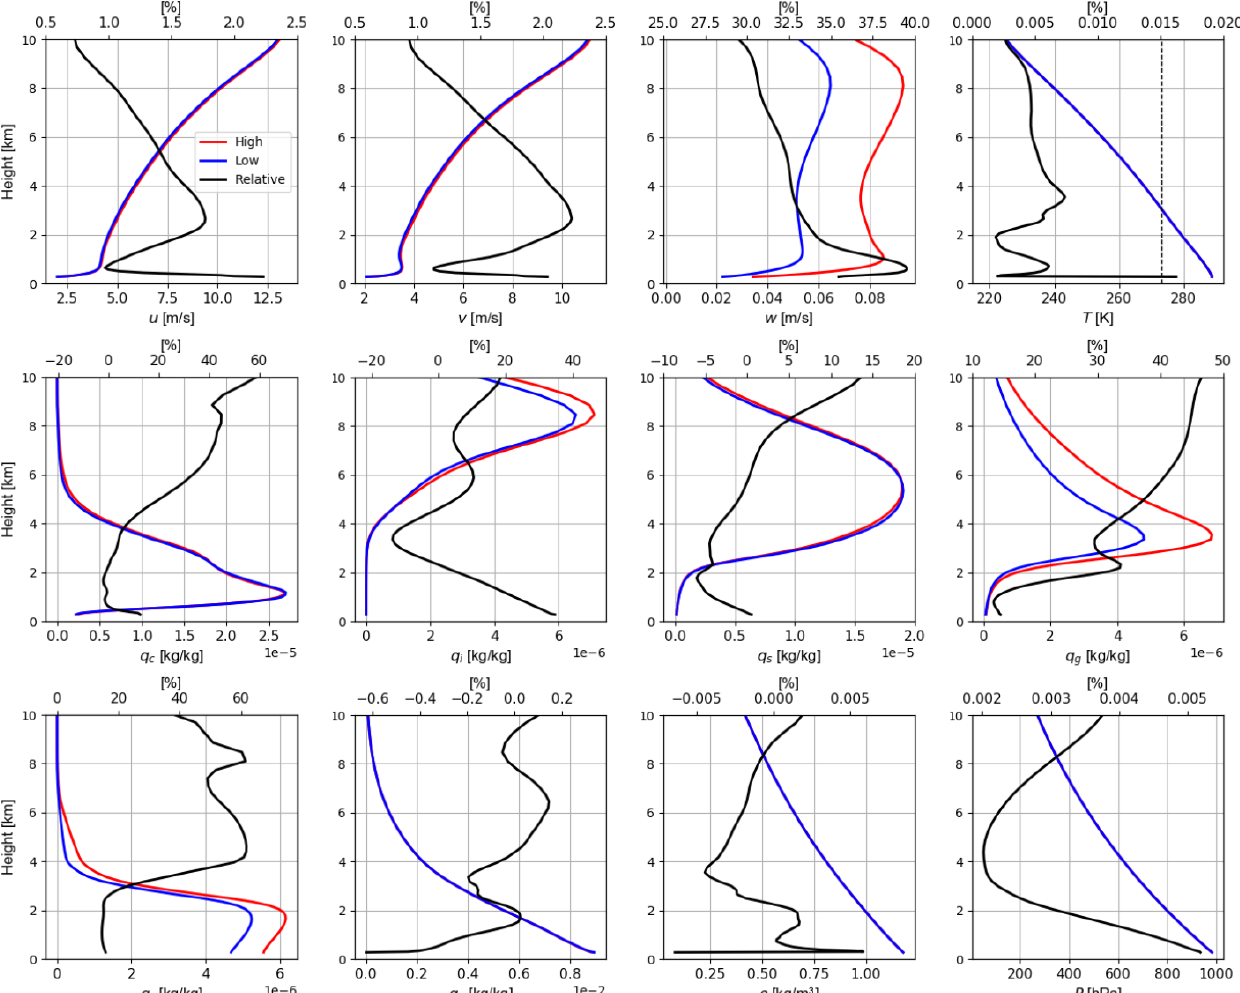
Figure 5. Vertical profiles of model variables such as horizontal wind (u,v) , vertical wind w , temperature T , mixing ratios of cloud water q c , cloud ice q i , snow q s , graupel q g , rain q r and water vapor q v , as well as air density ρ and pressure P in high- (1.0km) and low-resolution (2.1km) model runs. The absolute values of model variables averaged over the entire period are shown. The vertical dashed black line in the figure for T indicates 273K. The solid black line is the relative difference [%] (the upper x